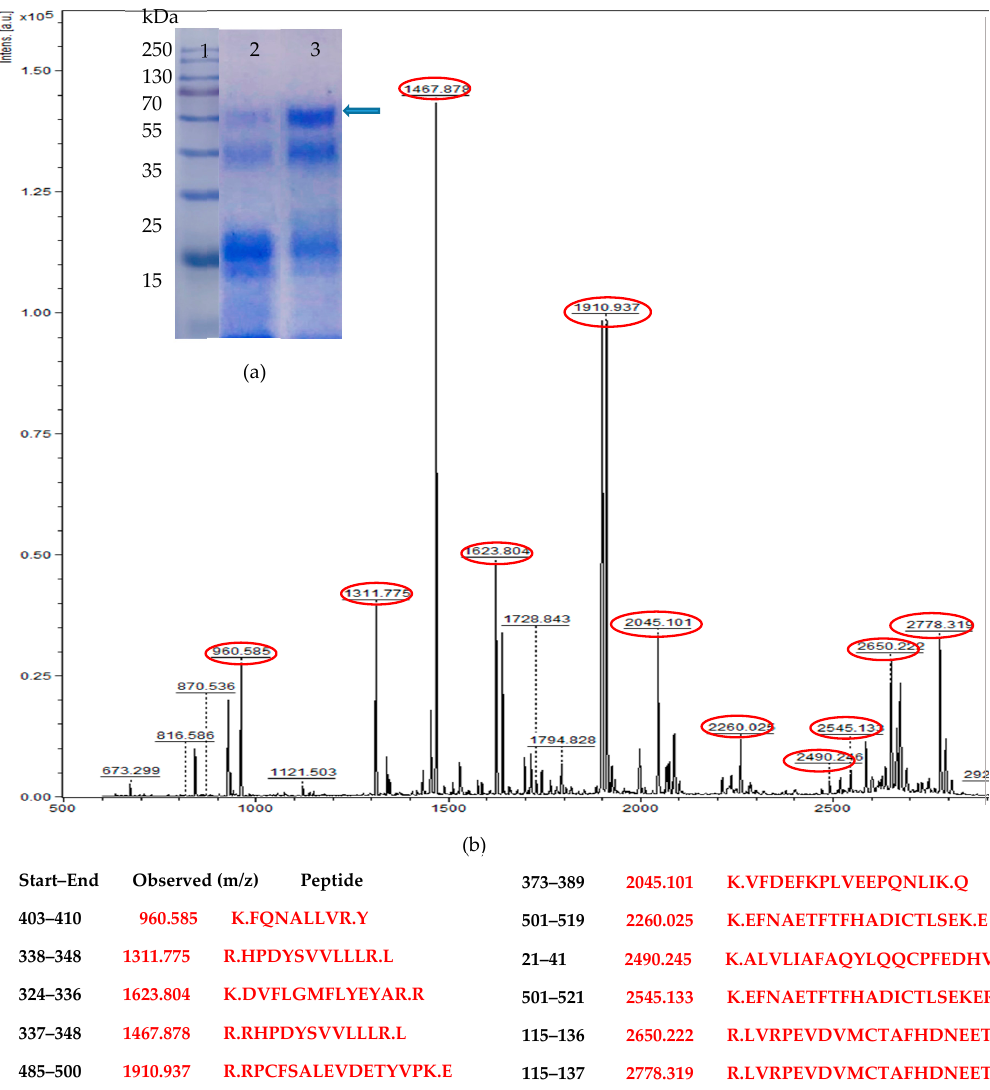
R.LVRPEVDVMCTAFHDNEETFLKK.Y Figure 2. ( a ) Sodium dodecyl sulfate-polyacrylamide gel electrophoresis (SDS-PAGE) analysis of the total extracellular protein produced under unoptimized (Standard Invitrogen) conditions, Lane 1: Protein Ladder. Culture supernatant (20 µL) from Clone # 52 (single copy HSA): Lane 2, and Clone # 14 (two-copy HSA): Lane 3. Arrow indicates the HSA band. ( b ) Matrix-assisted laser desorption/ionization-time-of-flight (MALDI/TOF) peptide spectrum of the protein band from Clone # 14.